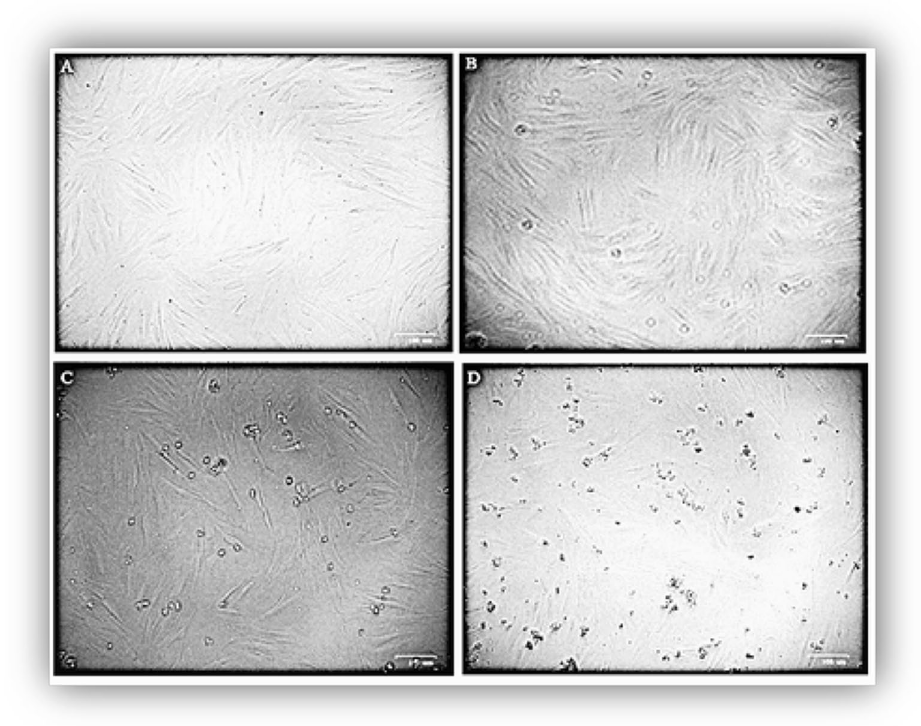
Figure 3. Morphology of fibroblast cells; ( a ) Control cells, ( b ) Cells treated with 3.12 μg/ml, ( c ) 6.25 μg/ml, ( d ) 12.5 μg/ml of the isolated compound.